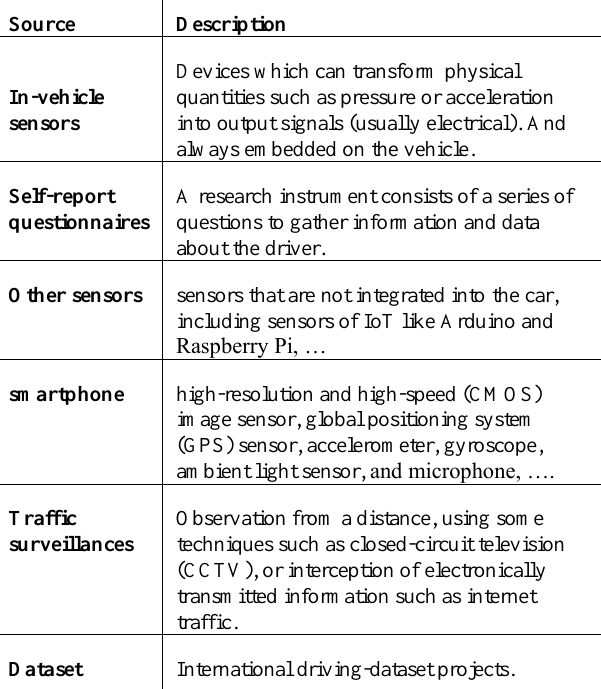
Table 2. Description of measurement techniques used to collect